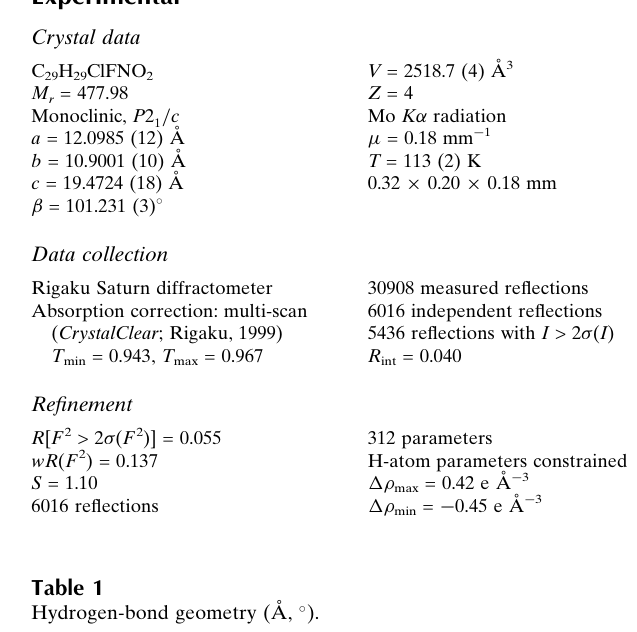
Hydrogen-bond geometry (A˚ , (cid:2) ). D —H (cid:1)(cid:1)(cid:1)